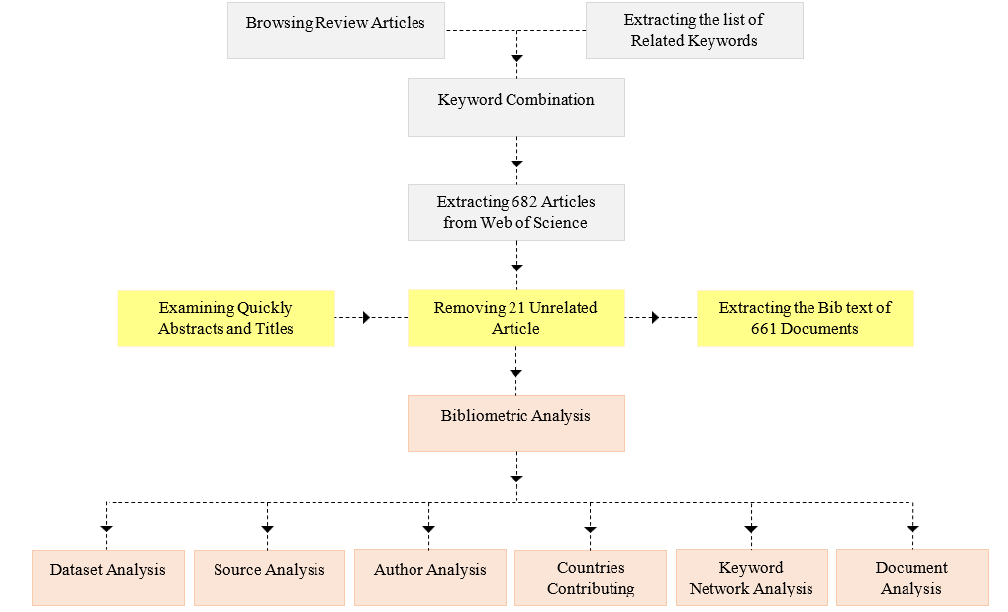
Fig. 3. Steps of Bibliometric Analysis